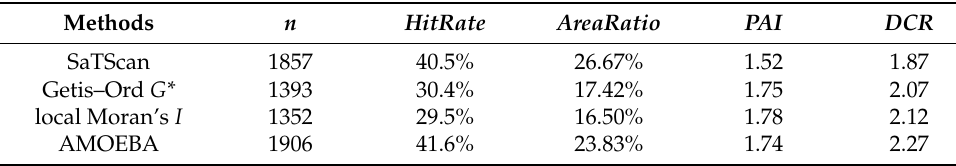
Table 2. Case-based evaluation results of hotspots on synthetic